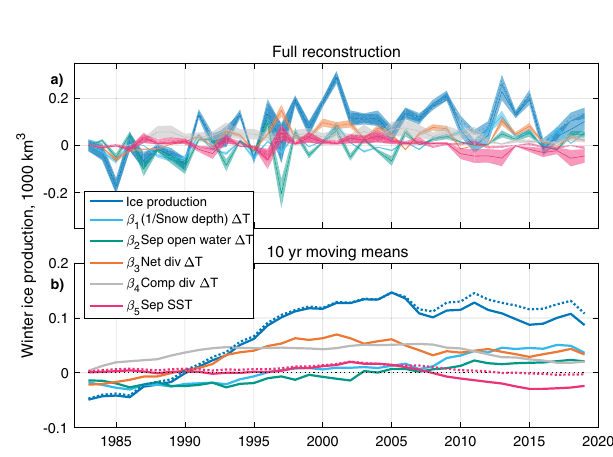
Fig. 8 | Application of linear model to historical changes. Changes in winter ice production in the Kara-Laptev seas plotted relative to the fi rst winter of the recon- struction (1982/1983). The estimate uses climate variables from observation-based estimates and the linear model trained on CESM-LE internal variability. Data are plotted with respect to the new year of the winter in question. Dashed line is the result of using NOAA OI V2 SST product, while the solid line uses HadISST. Shaded uncertainty windows are derived from the one standard deviation spreads of the correspondingestimatesusingthe40setsofregressioncoef fi cientsfromindividual models (see Fig. 5). Full interannual evolution is plotted in ( a ) and 10-year moving means are plotted in ( b ). ‘ Div ’ is short for divergence; ʻ comp ’ for